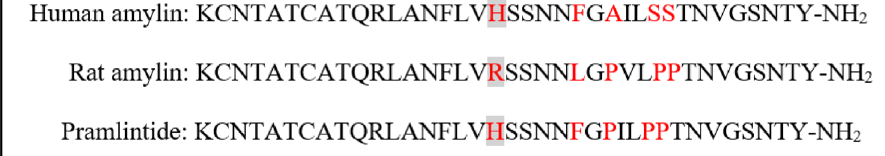
Figure 1. A comparison of the native sequence of human amylin, rat amylin and pramlintide. Sequential differences are marked in